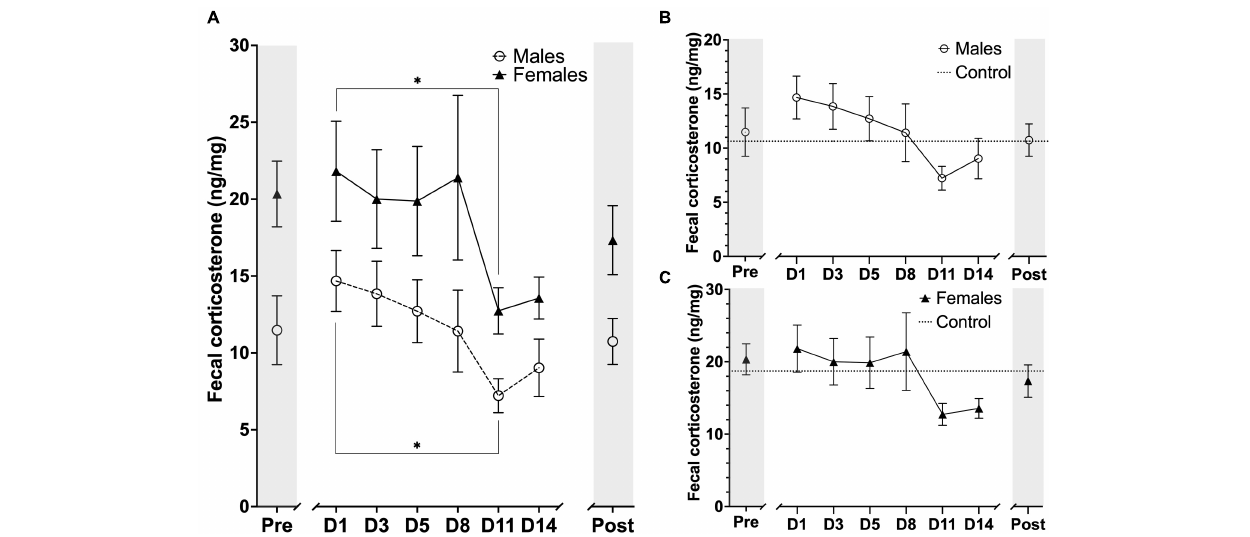
FIGURE 7 | Timeline representation of fecal corticosterone metabolite (FCM) concentration levels at the sampling timepoints during the experimental period. Units are displayed in FCM ng/mg of fecal matter. (A) FCM concentration for males ( n = 6 ) and females ( n = 6 ) at each sampling timepoint. (B) FCM concentration for males ( n = 6 ) and male controls ( n = 3). (C) FCM concentration for females ( n = 6 ) and mean FCM concentration for female controls ( n = 3). The markers on x-axis indicates the different sampling timepoints (Pre = after stable acclimatization; D1–14 = during the 14 days of MRI habituation; Post = 14 days after last MRI habituation day). The horizontal lines for control on figure B, C indicate mean FCM concentrations for the whole experimental period. Data points are presented as mean ± SEM. * P <